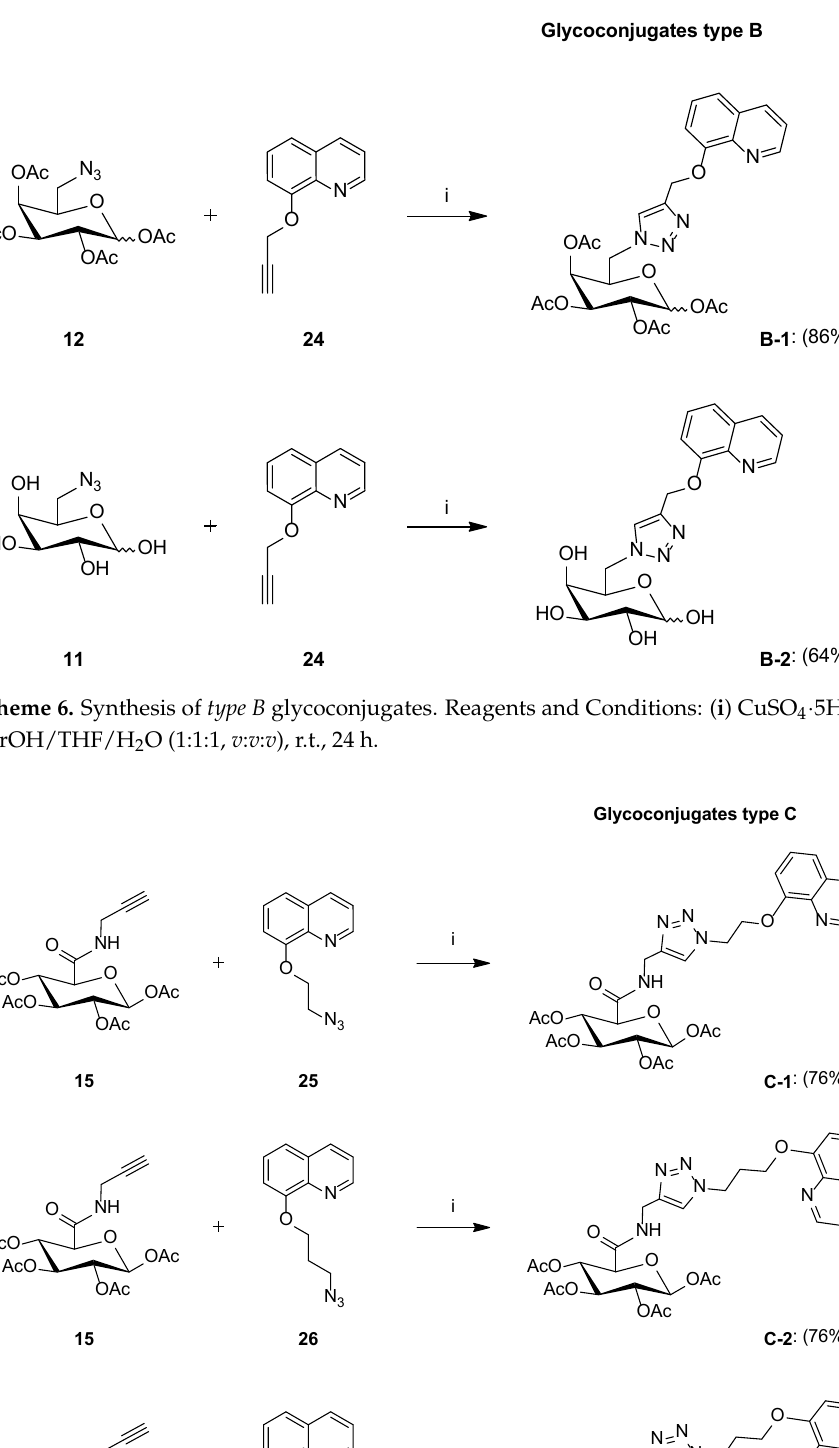
Scheme 5. Synthesis of type A glycoconjugates. Reagents and Conditions: ( i ) CuSO 4 ·5H 2 O, NaAsc, i - PrOH/THF/H 2 O (1:1:1, v : v : v ), r.t., 24 h.